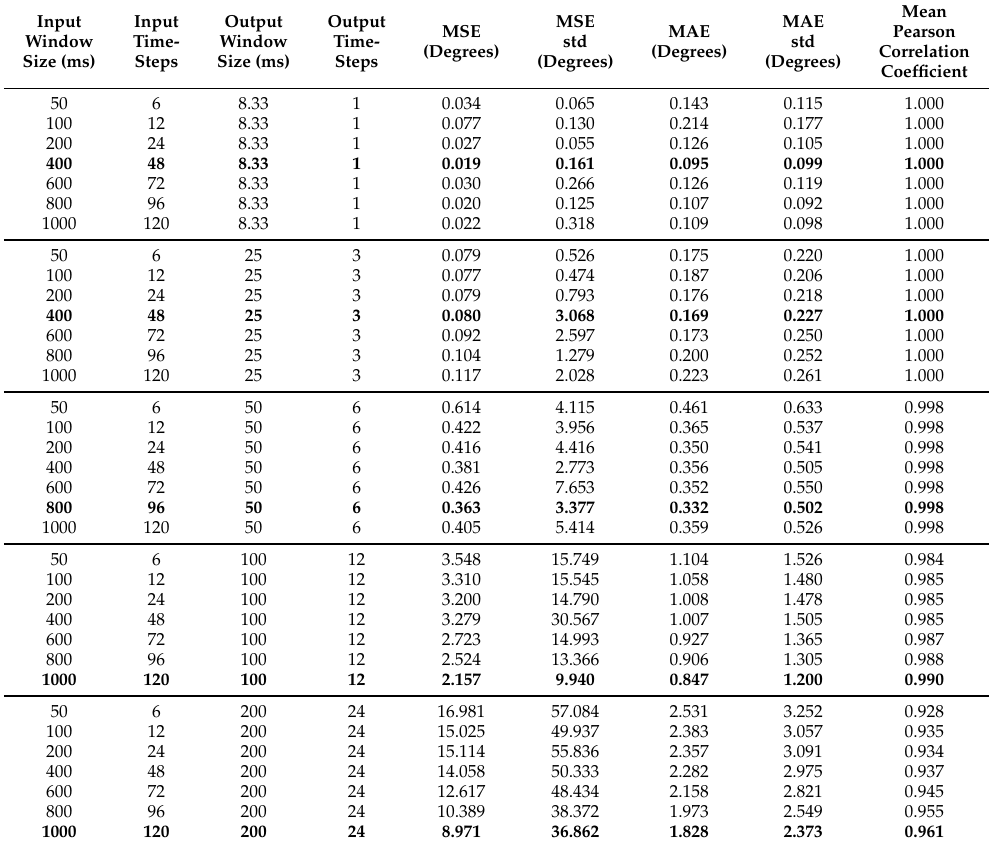
Table 2. Performance of LSTM in forecasting gait trajectories for varying input and output window